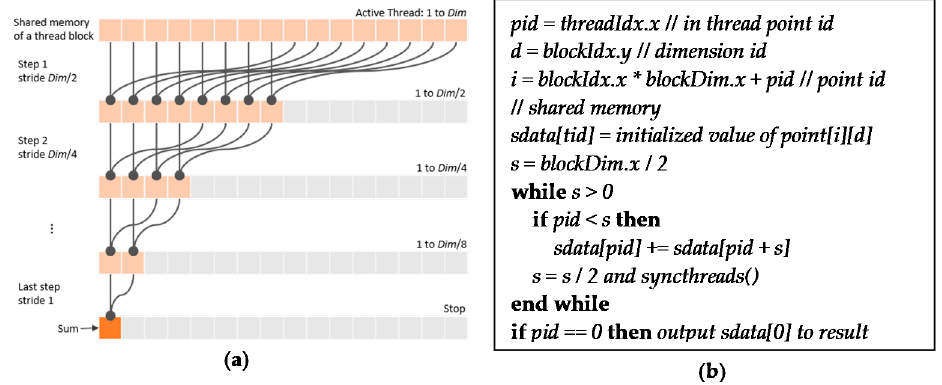
Figure 3. The parallel reduction. ( a ) Illustration of GPU thread block iterations. ( b ) The pseudo code of the GPU kernel implementation.